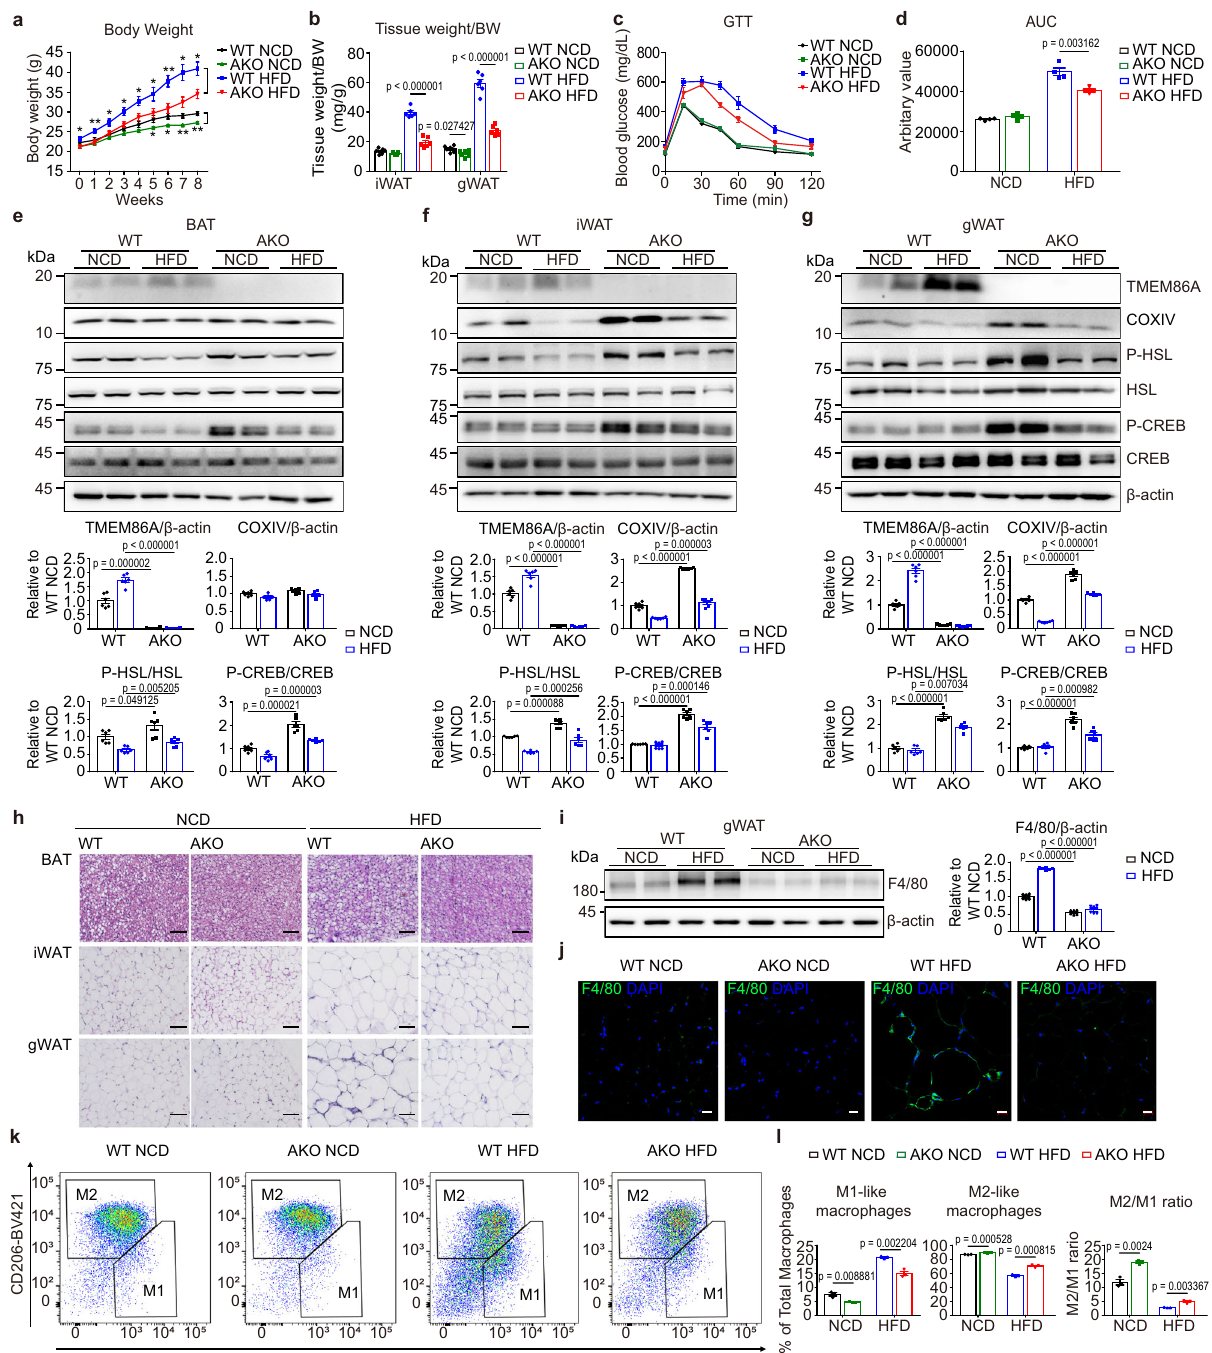
Fig. 6 Adipocyte-speci fi c TMEM86A KO protects mice against HFD-induced metabolic dysfunction and in fl ammation. a Body weight monitoring of WT and TMEM86A AKO mice during 8-weeks of HFD feeding. n = 6. (WT HFD vs. KO HFD: p = 0.015084, p = 0.006167, p = 0.042557, p = 0.026351, p = 0.019894, p = 0.040475, p = 0.004757, p = 0.010575, or p = 0.1215, respectively for week 0, 1, 2, 3, 4, 5, 6, 7, or 8; WT NCD vs. KO NCD: p = 0.039863, p = 0.010424, p = 0.003051, or p = 0.003318, respectively for week 5, 6, 7, or 8). b Weights of adipose tissue of WT and TMEM86A AKO mice fed a NCD or HFD. n = 6. c , d Intraperitoneal glucose tolerance test. n = 4. e – g Immunoblot analysis of BAT, iWAT and gWAT. n = 6. h H&E staining of paraf fi n sections of BAT, iWAT and gWAT. n = 6. Scale bar = 50 μ m. i Immunoblot analysis of F4/80 in gWAT. n = 6. j Immuno fl uorescence staining of F4/80 in paraf fi n sections of gWAT. n = 6. Scale bar = 20 μ m. k , l Flow cytometric analysis of CD45 + CD11b + CD64 + CD11C + cells (M1-like macrophages) and CD45 + CD11b + CD64 + CD206 + cells (M2-like macrophages) in gWAT. n = 3. Each point represents a biological replicate. Data are presented as mean ± SEM. Statistical signi fi cance was determined using the unpaired, two-tailed t -test in a , b , d , e – g , i , Source data are provided as a Source Data fi